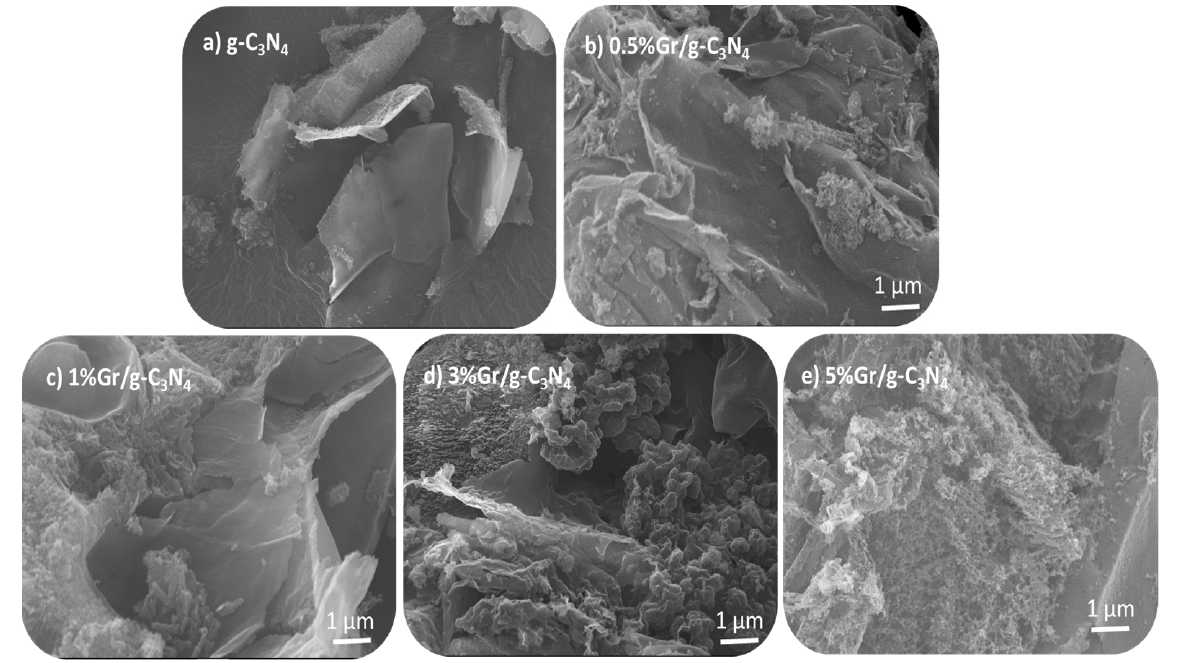
Figure 2. The SEM images of ( a ) g-C 3 N 4 , ( b ) 0.5%Gr/g-C 3 N 4 , ( c ) 1%Gr/g-C 3 N 4 , ( d ) 3%Gr/g-C 3 N 4 and ( e ) 5%Gr/g-C 3 N 4 samples.